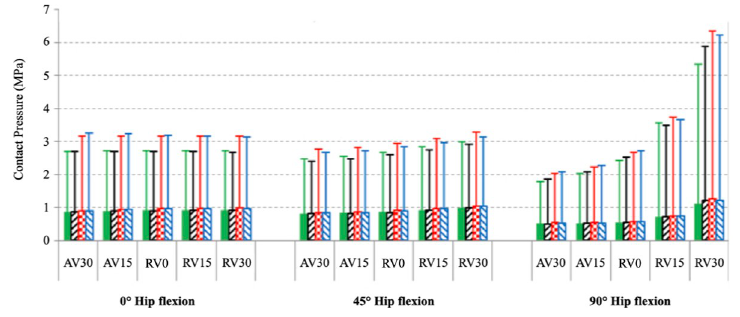
Fig 3. Contact pressure between the acetabular cup and head in different loading conditions and acetabular cup positions. Acetabular cup is position with 40˚ of inclination and 15˚ of version (green line); 40˚ of inclination and 25˚ of version (black line); 50˚ of inclination and 15˚ of version (red line); 50˚ of inclination and 25˚ of version (blue line).